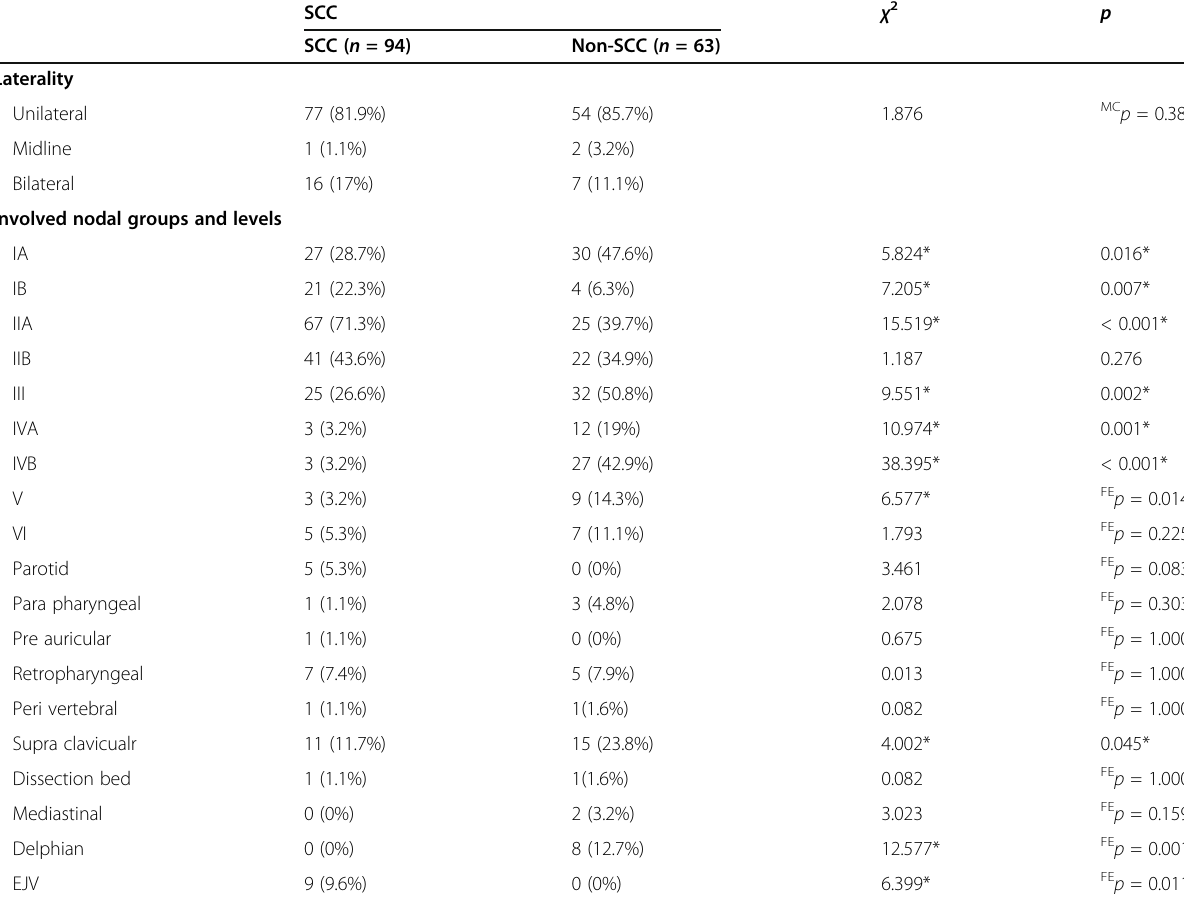
Table 3 Comparison between the two studied groups according to distribution (laterality and nodal